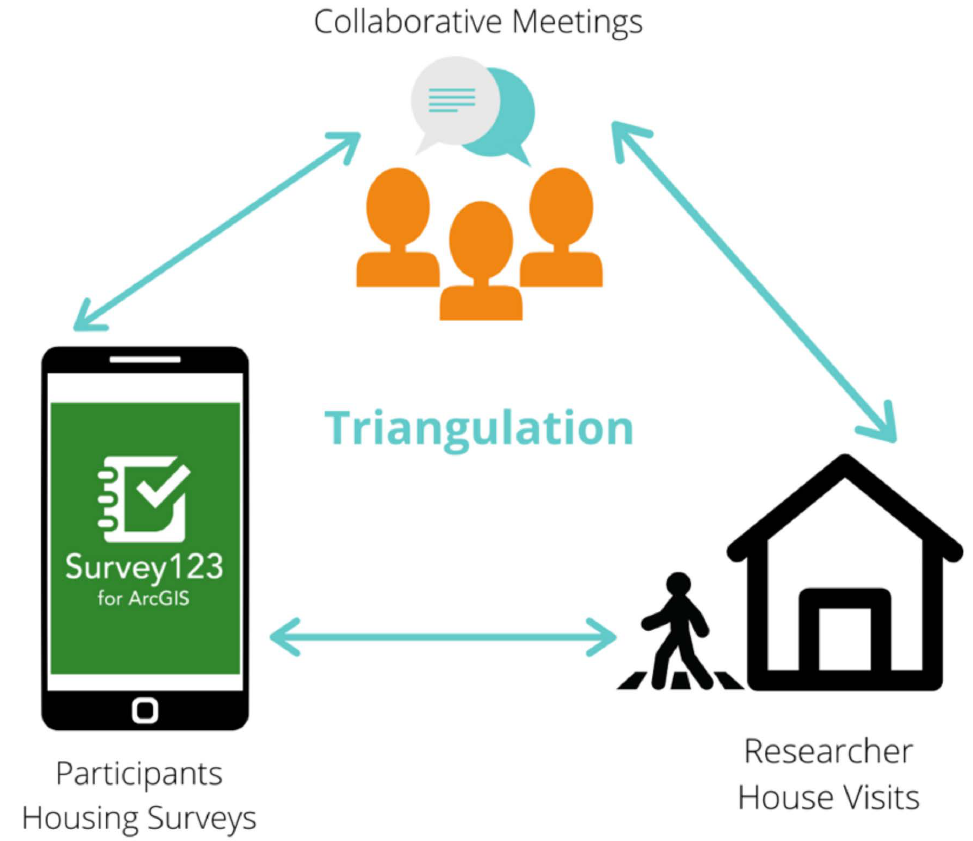
Figure 1. Methodological triangulation in study